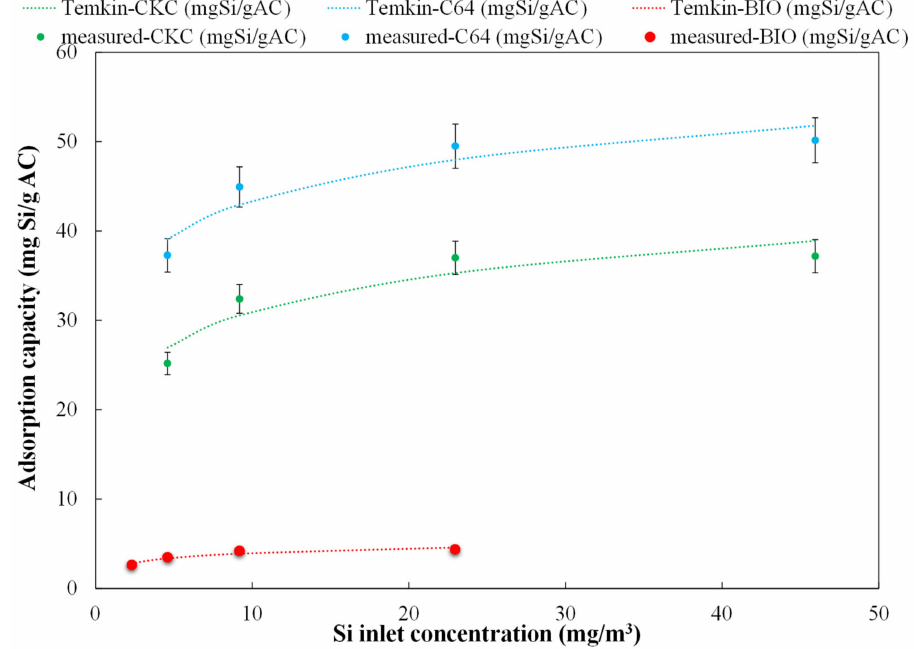
Figure 6. Temkin isotherm for D4 removal with biochar, C64, and